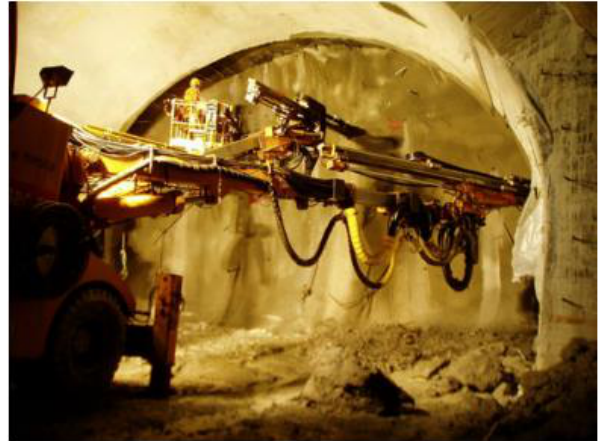
Figure 14. Collapse of the working face of Atlantic Ocean tunnel [87].